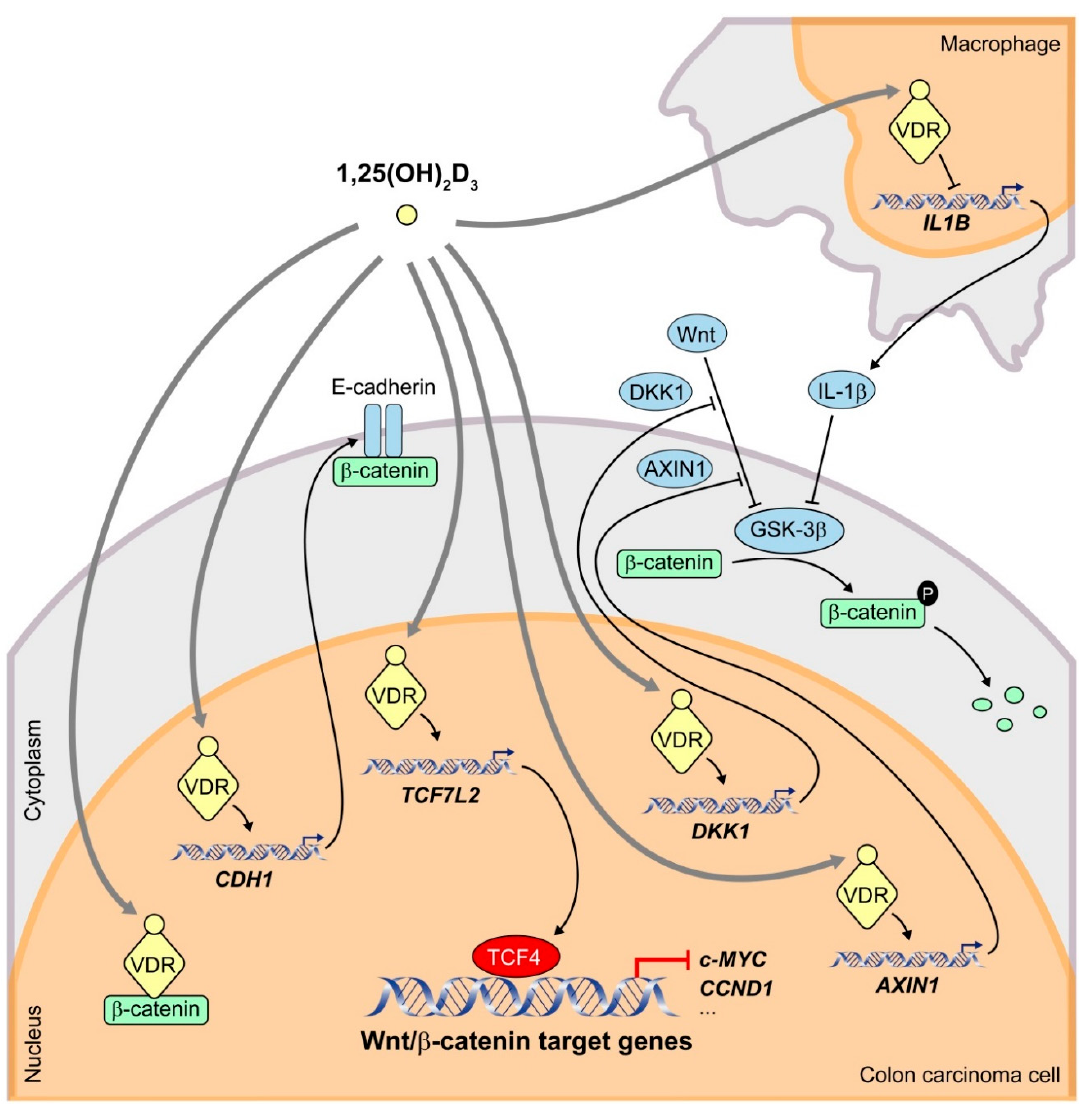
Figure 1. Schematic representation of the mechanisms by which 1,25(OH) 2 D 3 interferes the Wnt/ β -catenin signaling pathway in human CRC cells. 1,25(OH) 2 D 3 binds to its high affinity receptor VDR inducing the formation of β -catenin/VDR complexes and thus preventing that of transcriptionally active β -catenin/TCF4 complexes. In addition, 1,25(OH) 2 D 3 increases the transcription of the CDH1 gene encoding E-cadherin, which sequesters newly synthesized β -catenin protein at the subcortical adherens junctions. Furthermore, 1,25(OH) 2 D 3 upregulates the expression of the negative regulators of the Wnt/ β -catenin pathway TCF7L2 (encoding TCF4), DKK1 and AXIN1 . 1,25(OH) 2 D 3 also antagonizes the pathway by reducing the secretion by nearby macrophages of IL-1 β , which inhibits GSK-3 β activity in CRC cells leading to an increase in β -catenin levels.